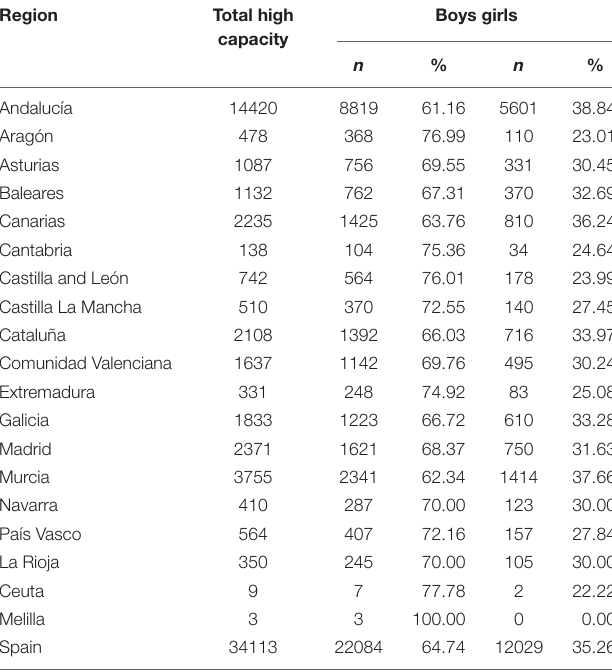
TABLE 1 | Prevalence of highly intellectually capable students in Spain by